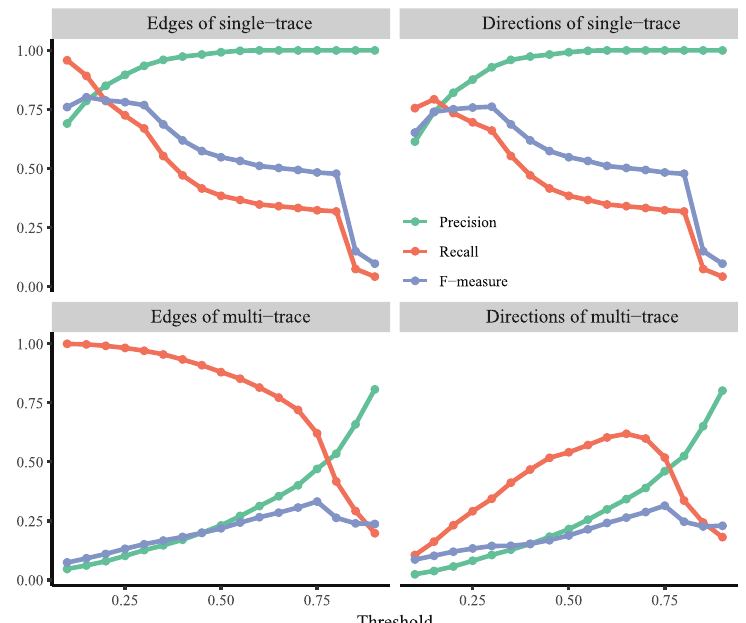
Figure 2. Results of Approach 0 for single-trace simulations ( top row ) and multi-trace simulations ( bottom row ) at different thresholds of “the strong correlation”.